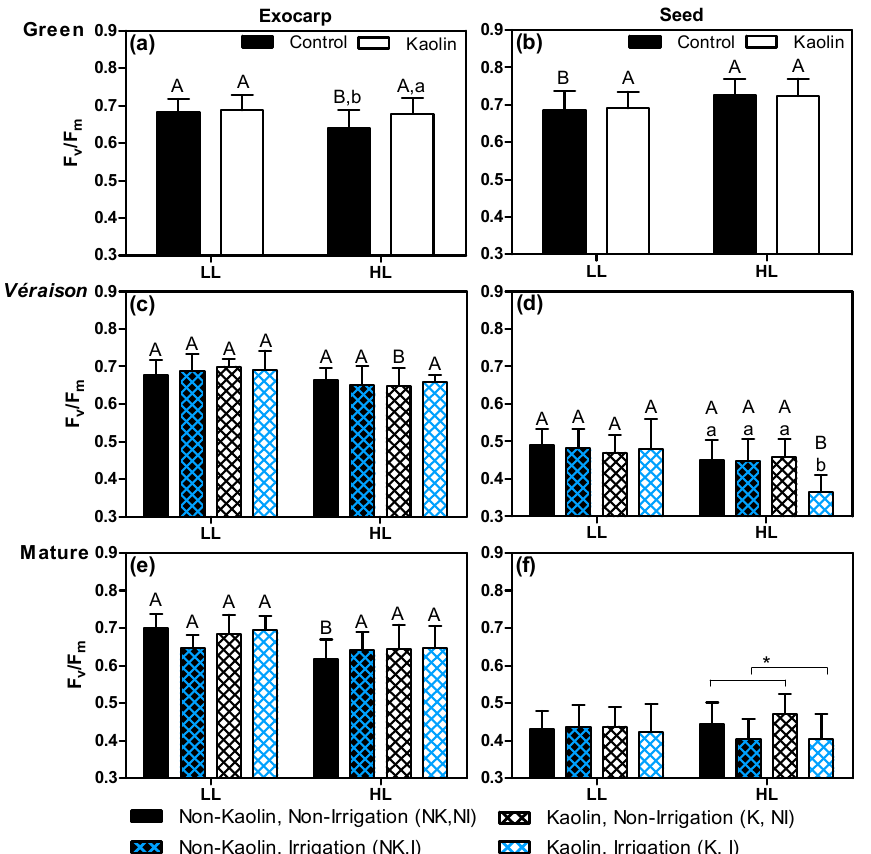
Figure 5. Maximum quantum e ffi ciency of PSII (F v / F m ) mean values ( n = 12–24 berries, + SD) of exocarps and seed integuments obtained from dark-adapted LL and HL grape berries grown under the four combinations of the two treatments applied: irrigation (I) / non-irrigation (NI) × kaolin (K) / non-kaolin (NK). Samples were collected at three development stages (green, v é raison, and mature). Statistical notation: for each developmental stage, capital letters refer to di ff erences between light microclimates within the same treatment combination, and lowercase letters refer to di ff erences between treatment combinations within each light microclimate (mean values with a common letter were not significantly di ff erent). When capital and lowercase letters are omitted, the respective factor did not have a significant e ff ect (two-way ANOVA p > 0.05). Notation with an asterisk means that only one factor (kaolin or irrigation) was